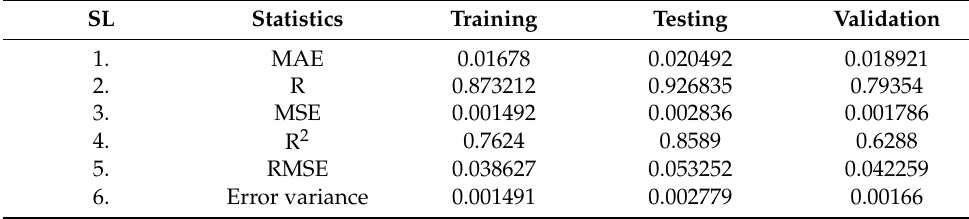
Table 4. Error statistics of GA-ANN model at Polavaram, Godavari River